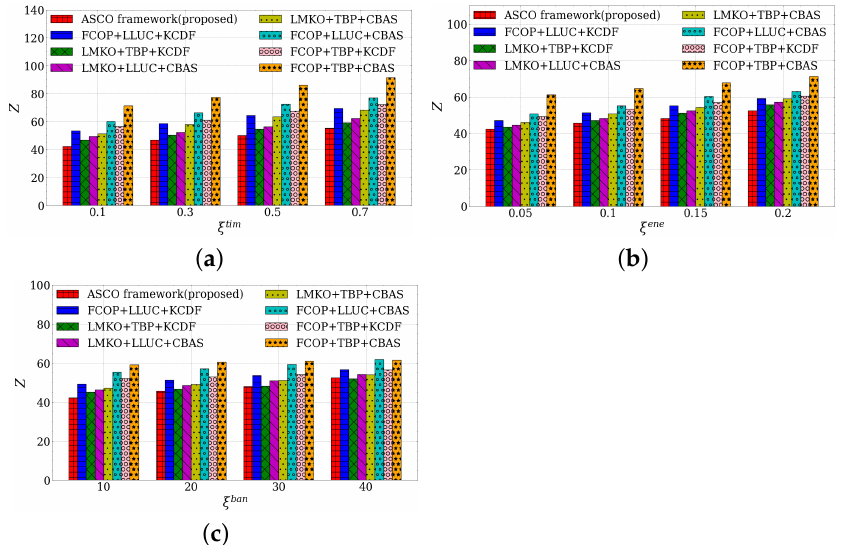
Figure 5. Performances under different baseline combinations. ( a ) Average time cost. ( b ) Average energy cost. ( c ) Average bandwidth